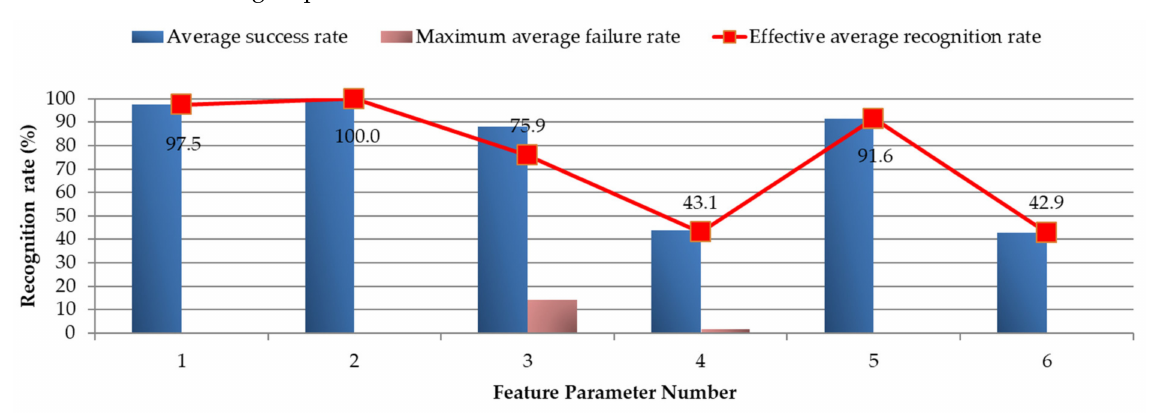
Figure 36. GIS-3 partial discharge parameter: basic discharge parameter recognition rate.